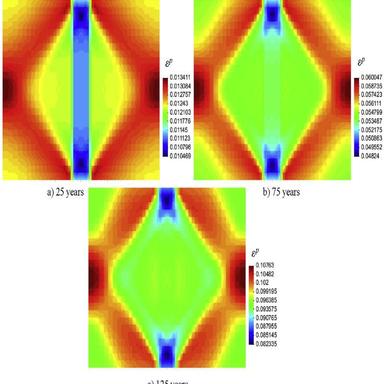
Equivalent plastic strain p distribution with time.